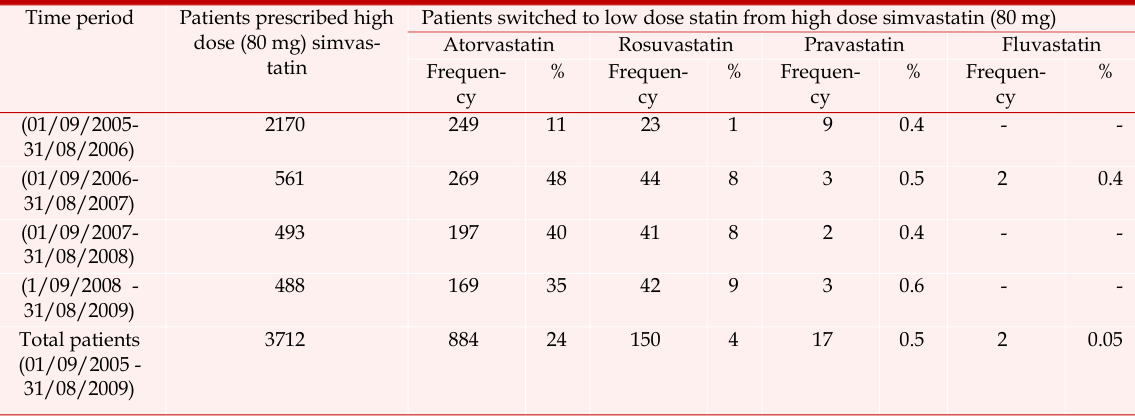
Frequency and percentage of patients switched to low dose statin from high dose (80 mg) simvastatin Time